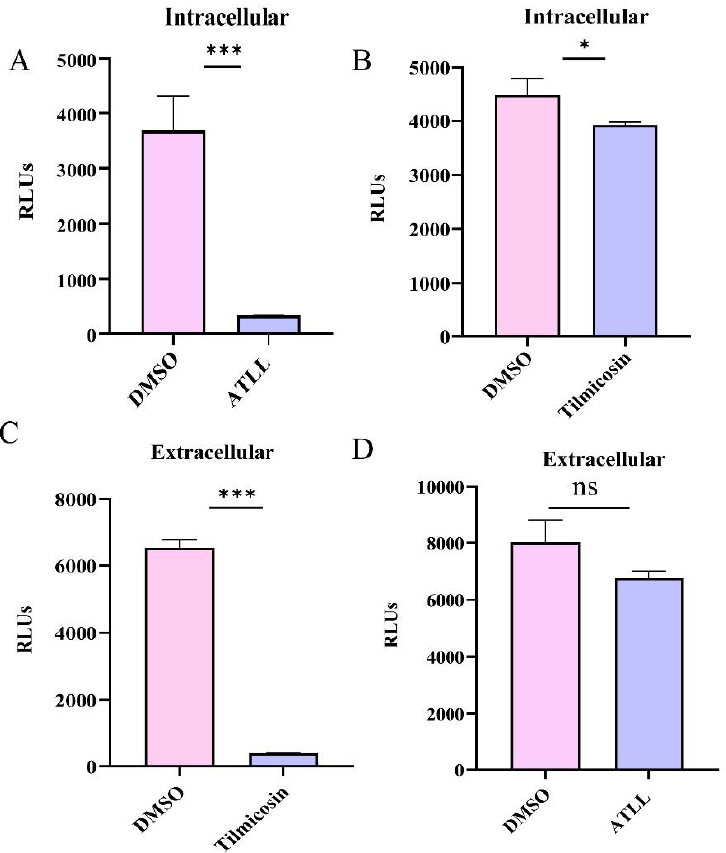
Figure 3. Differential effects of tilmicosin and ATLL on intracellular and extracellular tachyzoites. Vero cells were infected with 1 × 10 5 TgRH-Luc parasites for 1 h and then cultured with tilmicosin ( A ) or ATLL ( B ). After 24 h, cells and parasites were lysed and the relative luminescence (RLUs) were measured. Parasites were pretreated extracellularly with tilmicosin (35.92 µ M) ( C ) or ATLL (21.34 µ M) ( D ) for 3 h, then centrifuged to remove the drug and inoculated onto Vero cells in 96-well plates. After 24 h, cells and parasites were lysed and the RLUs were measured. Experiments were repeated three times. The intracellular and extracellular RLUs of parasites after treatment with tilmicosin or ATLL indicates TgRH-Luc activity. These values represent means ± SD (n = 3). Asterisks indicate statistically significant results. n.s. = not significant, *** p < 0.001, and * p < 0.05.